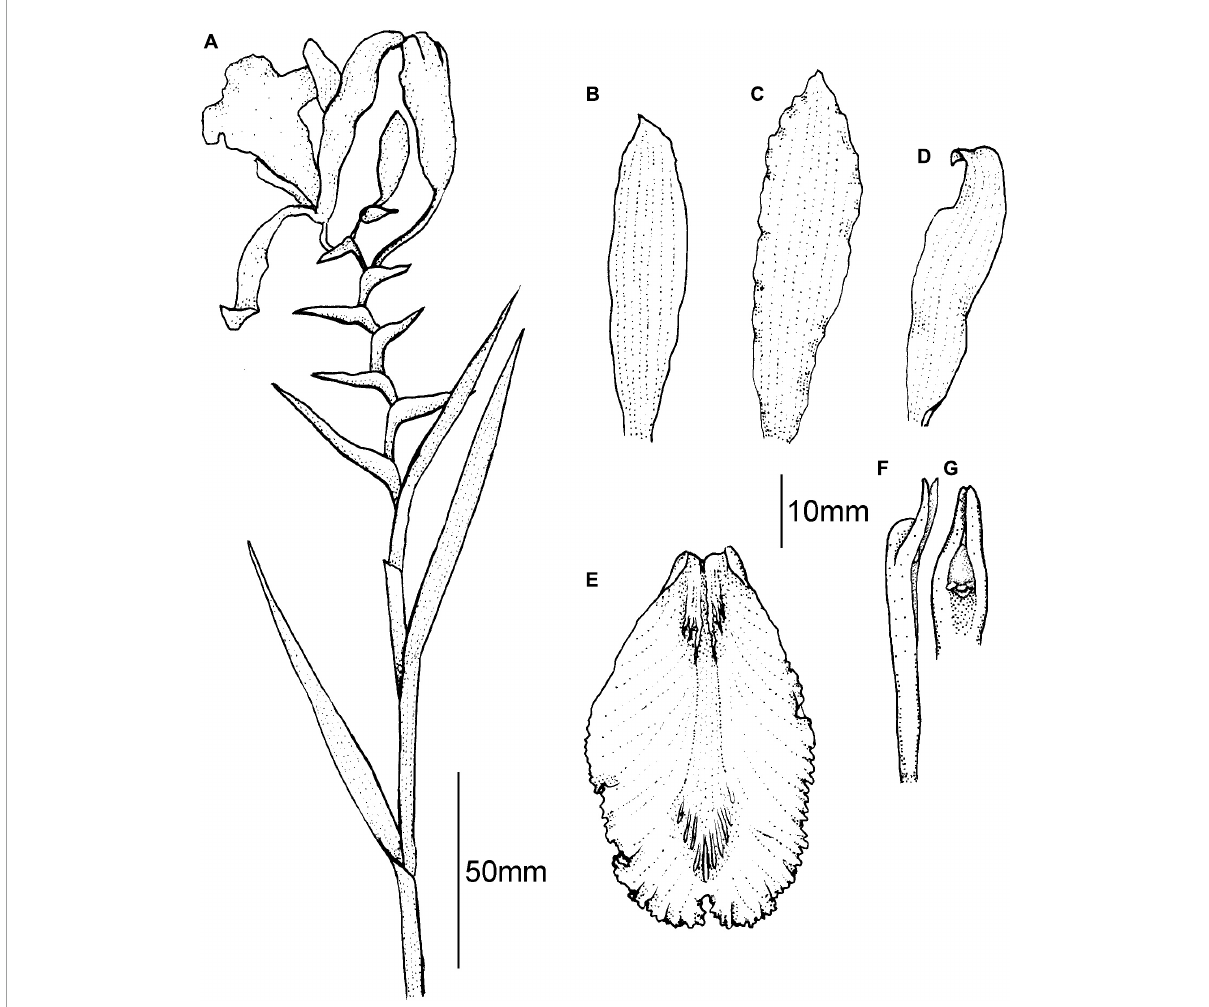
FIGURE5 Sobralia elisabethae R. H. Schomb. (A) apical part of stem with inflorescence, (B) dorsal sepal, (C) petal, (D) lateral sepal, (E) lip, (F) gynostemium, side view, and (G) apical part of gynostemium, front view [drawn by P. Baranow, panel (A) from lectotype, (B–G) redrawn from Romero-González